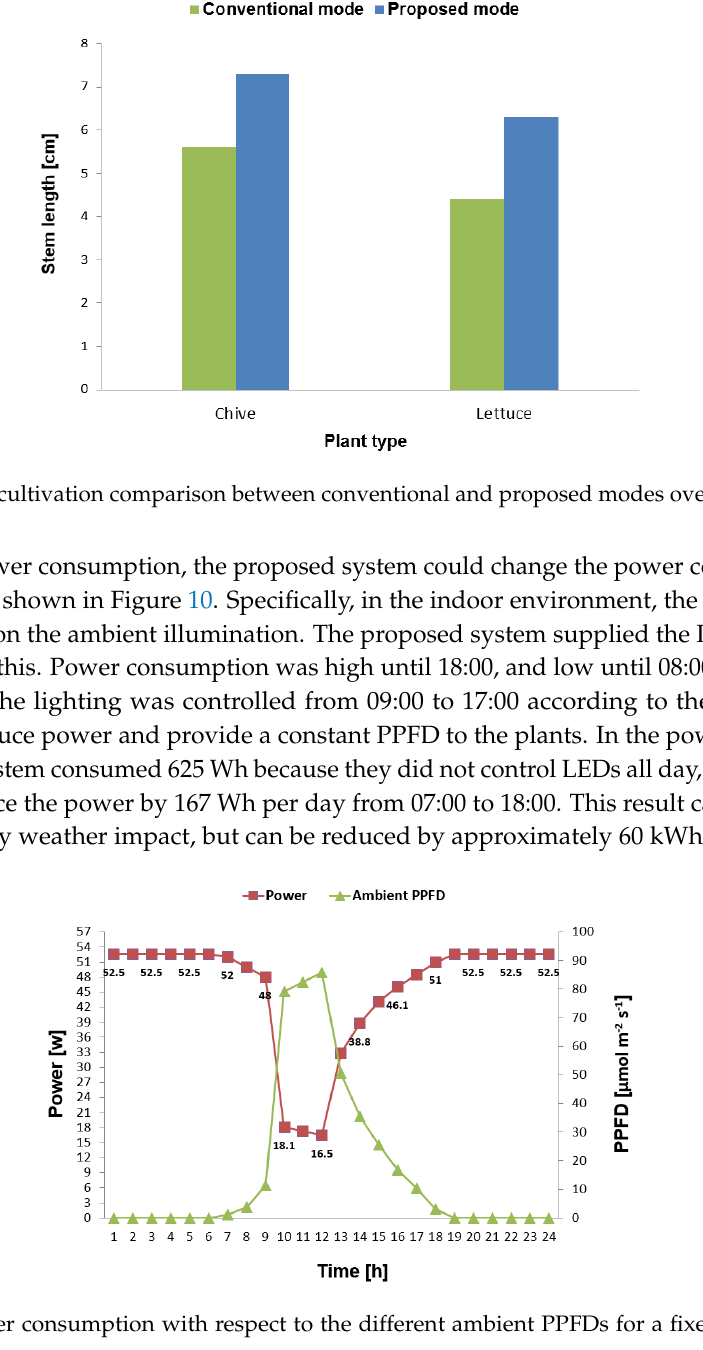
Figure 10. Power consumption with respect to the different ambient PPFDs for a fixed distance of 0.9 m.